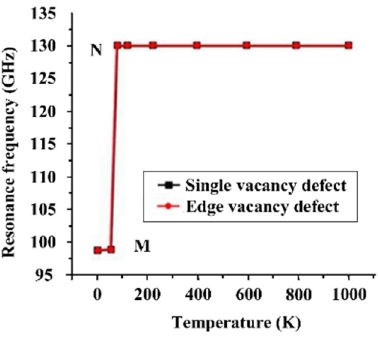
Figure 9. Resonance frequency as a function of temperature with two different vacancy defects.